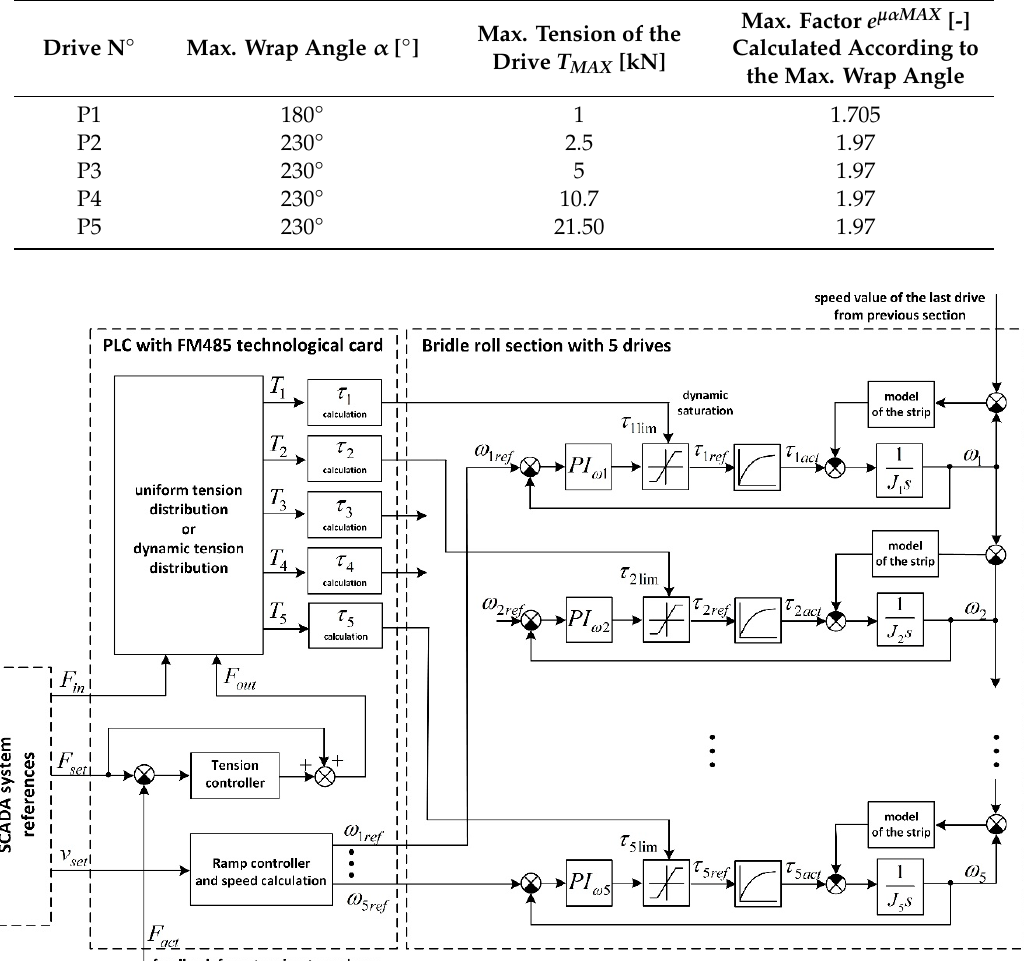
Figure 4. Symbolic control structure for the tension distribution algorithm for a leveler roll section with five drives.